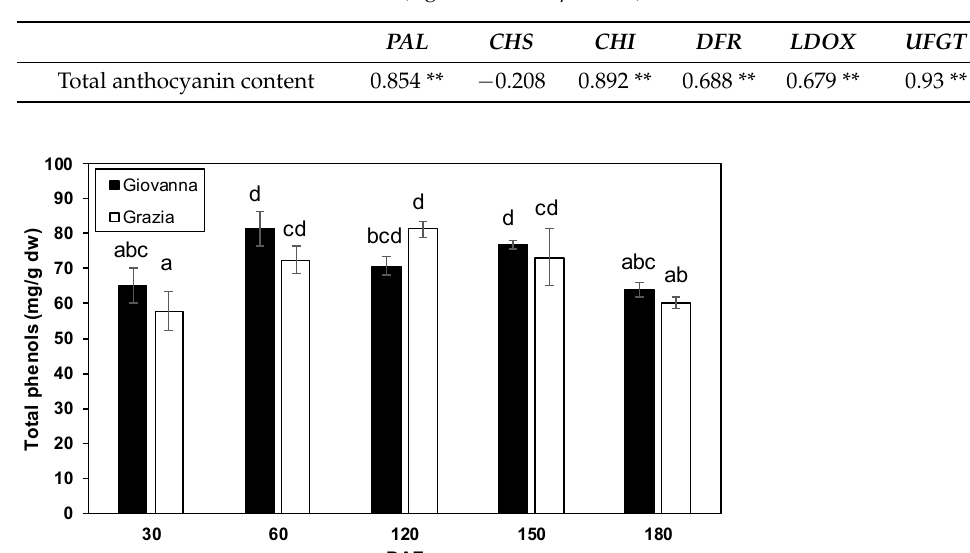
Figure 4. Total phenolic content at different development stages of “Giovanna” (dark-blue) and “Grazia” (white) fruit. Error bars represent the standard error of the mean of three biological repli- cates. Every replication consisted of 40 berries. Different letters represent statistically significant differences with Tukey’s B-test ( p < 0.05). Tukey’s B-test was carried out by comparing all means calculated at different DAFs for both cultivars.